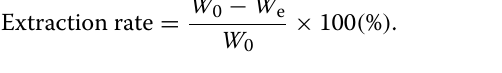
weight ( W e ) with the electric scale (Fig. 1a, b). The extrac- tion rate was calculated by Eq. 1 using W 0 and W e :